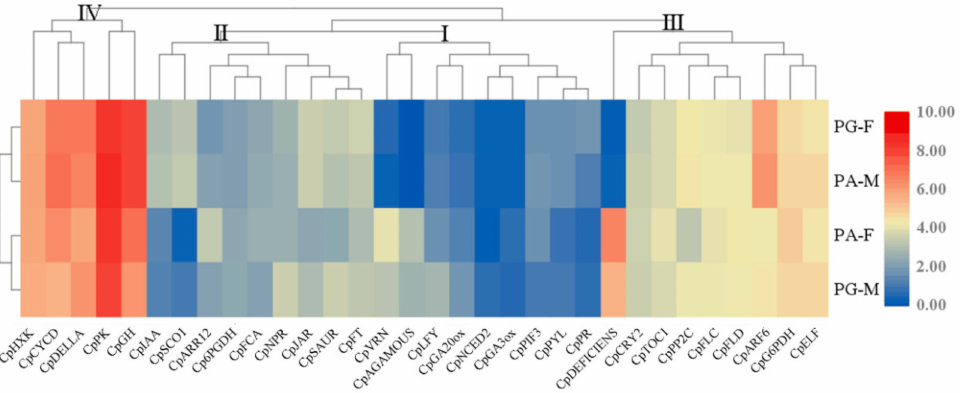
Figure 4. Heat map diagram of relative expression levels and classification based on the expression patterns of the related genes in